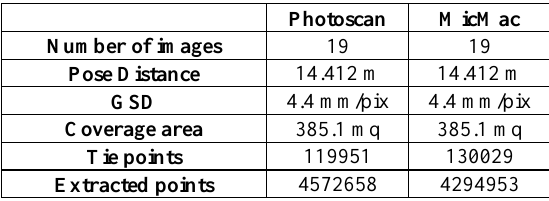
Table 1 - Results of Photoscan (high settings) and MicMac model reconstruction processing